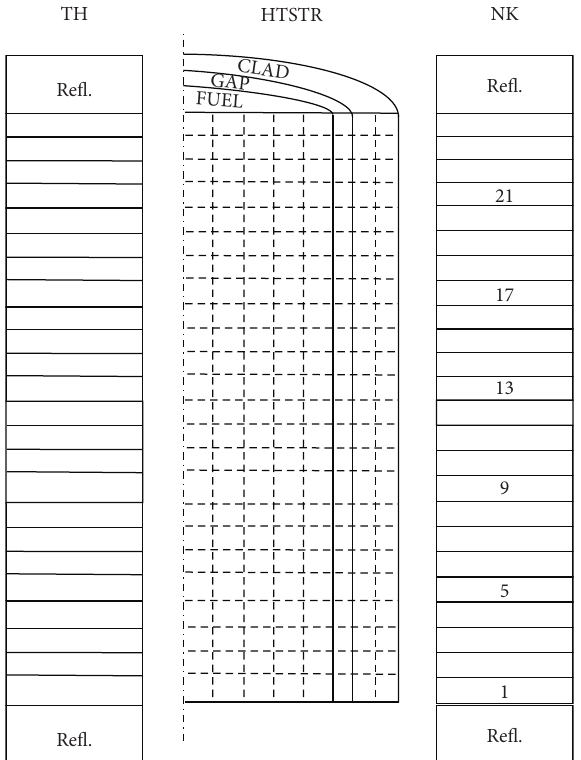
Figure 17: Nodalization and mapping of thermal-hydraulics (TH), neutronics kinetics (NK), and heat structure (HTSTR) models in the coupled depletion simulation.